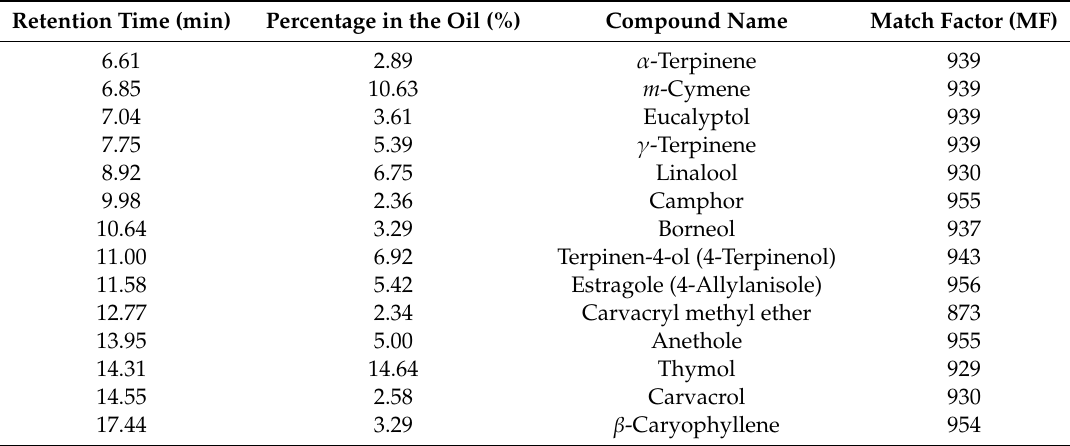
Table 2. GC-MS results for the extract of Origanum vulgare .